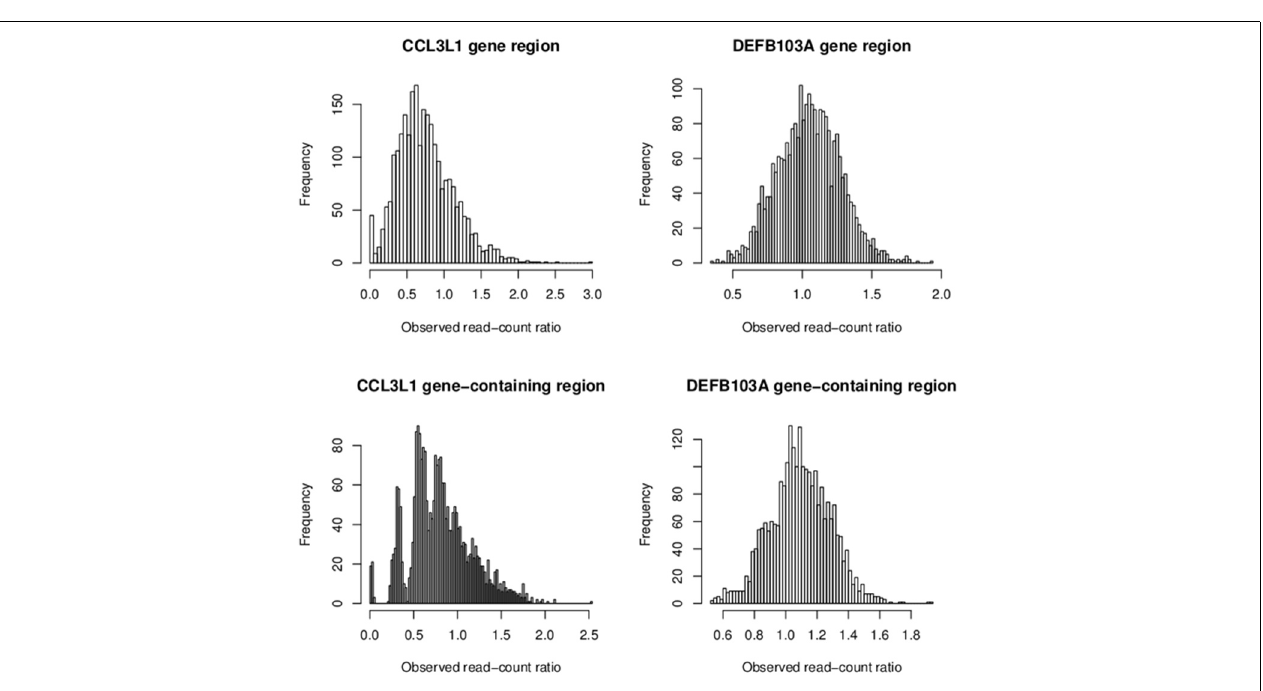
(1893/2535) of samples had ratio < 1, 76.4% (1938/2535) for the 35kb CCL3L1 region. Reads of samples having zero copies which were aligned to CCL3L1 gene region were very close to zero ( Table 4 ), and thus the density of reads at CCL3L1 was not